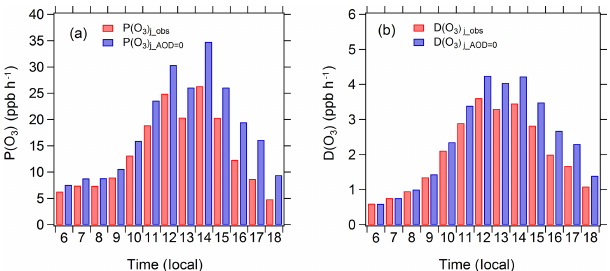
Figure 10. Diurnal profiles of mean P( O 3 ) j _obs , P( O 3 ) j _AOD = 0 , D( O 3 ) j _obs , and D( O 3 ) j _AOD = 0 in August 2012 under clear-sky